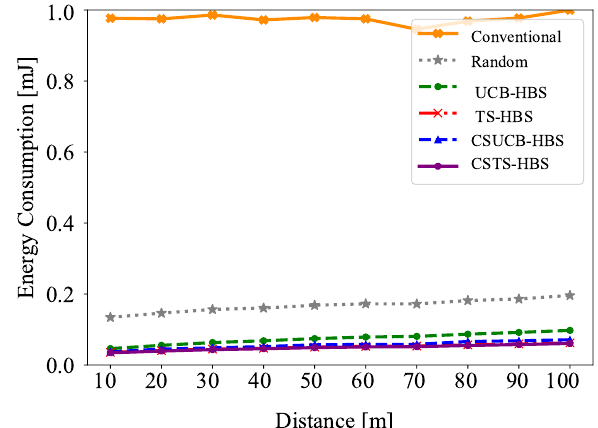
Figure 4. Energy consumption vs. r without considering blockage.